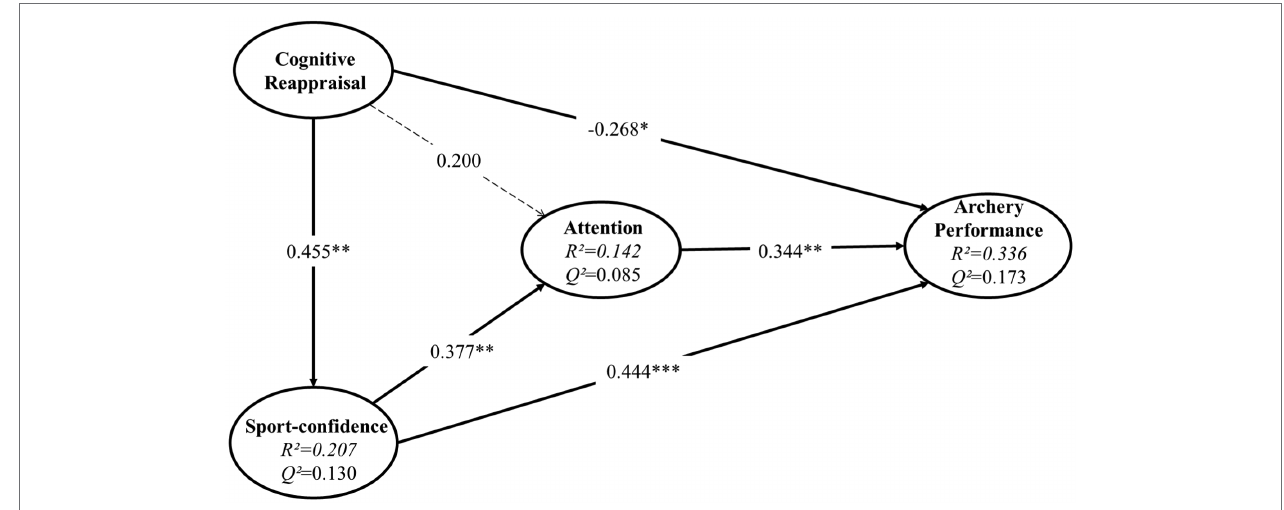
FIGURE 2 | Structural model and PLS-SEM results. * p < 0.05, ** p < 0.01, *** p <